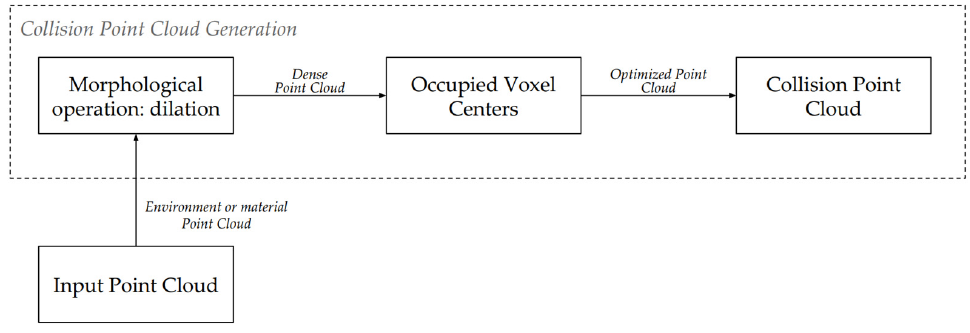
Figure 8. Processes to obtain the collision point cloud.